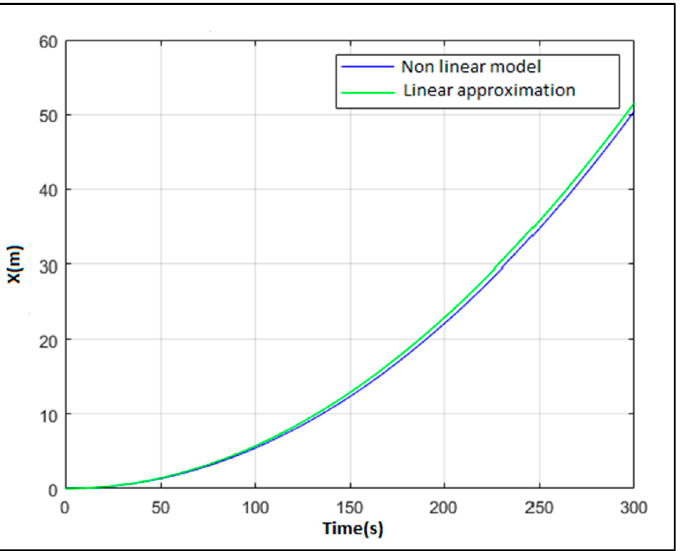
Figure 3. Validation of the linear approximation for the surge degree of freedom. Step input = 10,000 N.